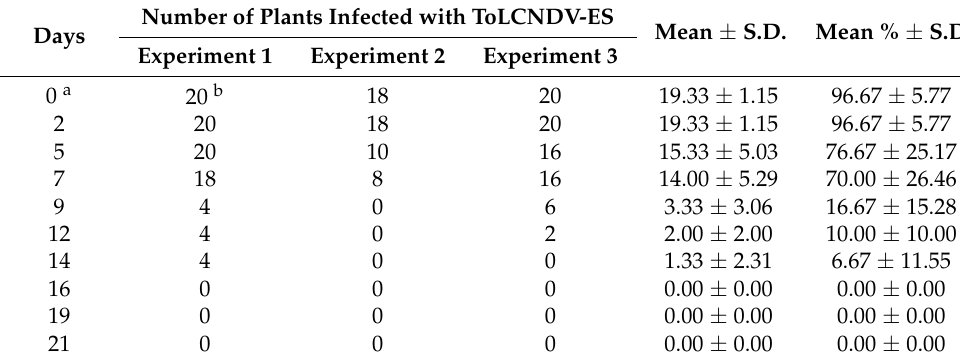
Table 4. Persistence of infectivity by adults B. tabaci